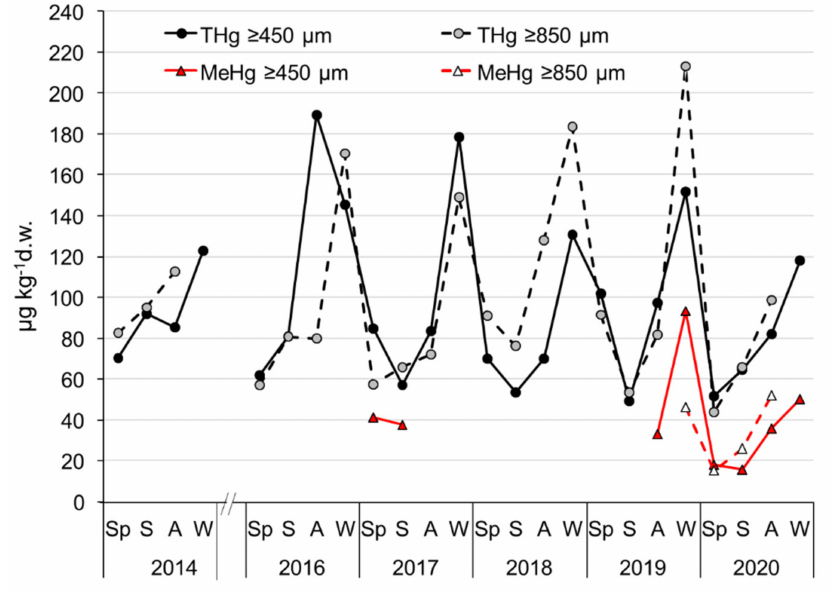
Figure 2. Seasonal changes in mercury concentrations (total mercury and methylmercury) in two zooplankton size fractions of Lake Maggiore during the years 2014 and 2016–2020. Sp = spring; S = summer; A = autumn; W = winter. For further explanations, see